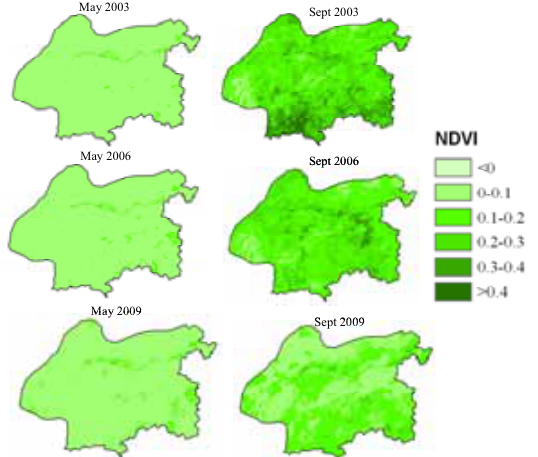
Figure 3. Location of study area in the Indian Thar desert and observation points in Jaisalmer district